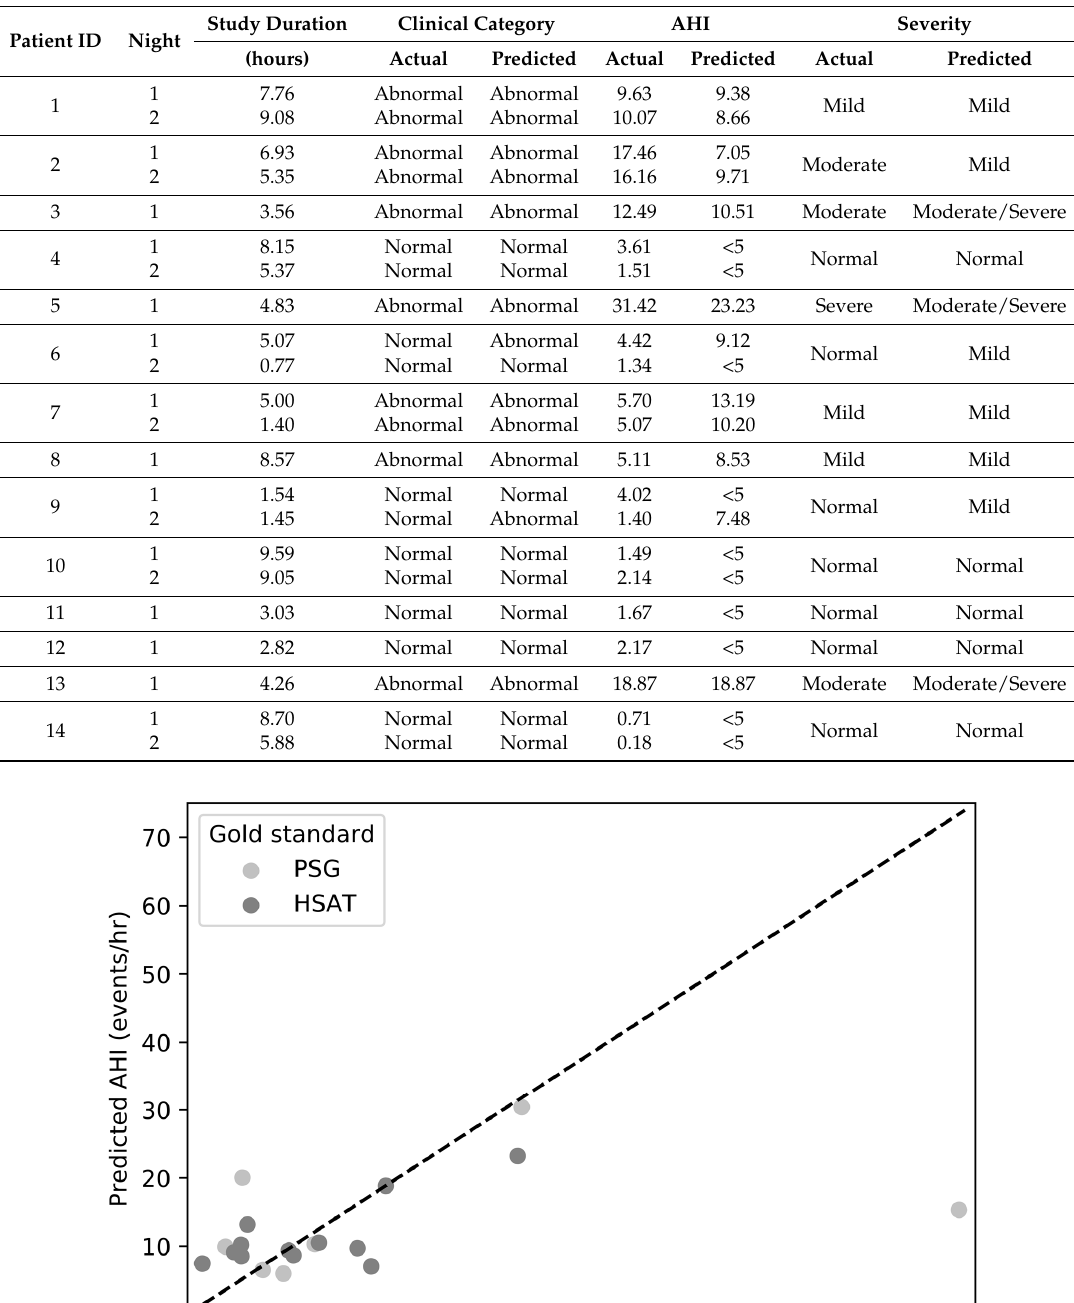
Table 3. In-home unattended sleep apnea testing using HSAT + LCs.